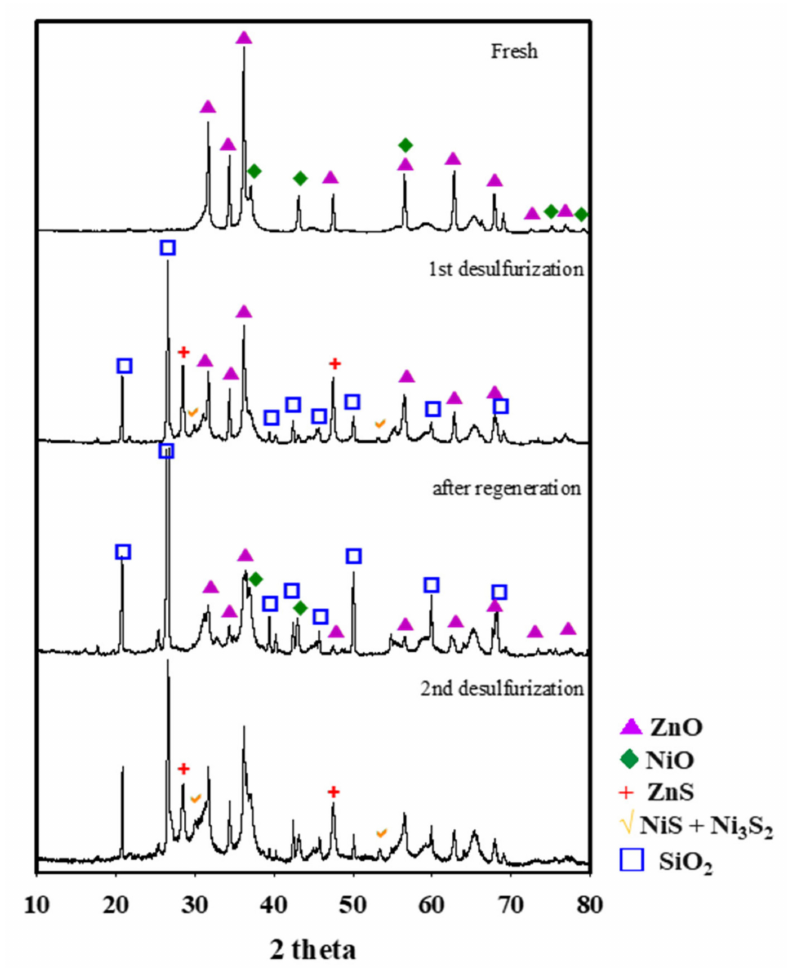
Figure 3. XRD patterns of the fresh, sulfurized, and regenerated sorbents (SC-229TD) in the repeated desulfurization and regeneration